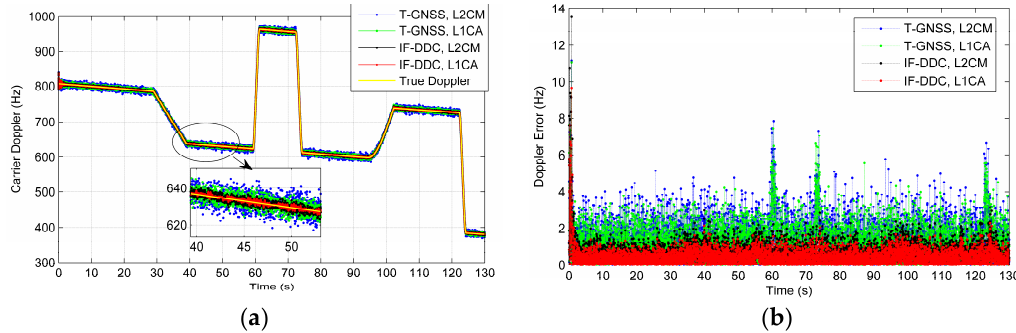
Figure 11. Carrier frequency tracking performance of SV #12: ( a ) carrier Doppler; ( b ) Doppler error.